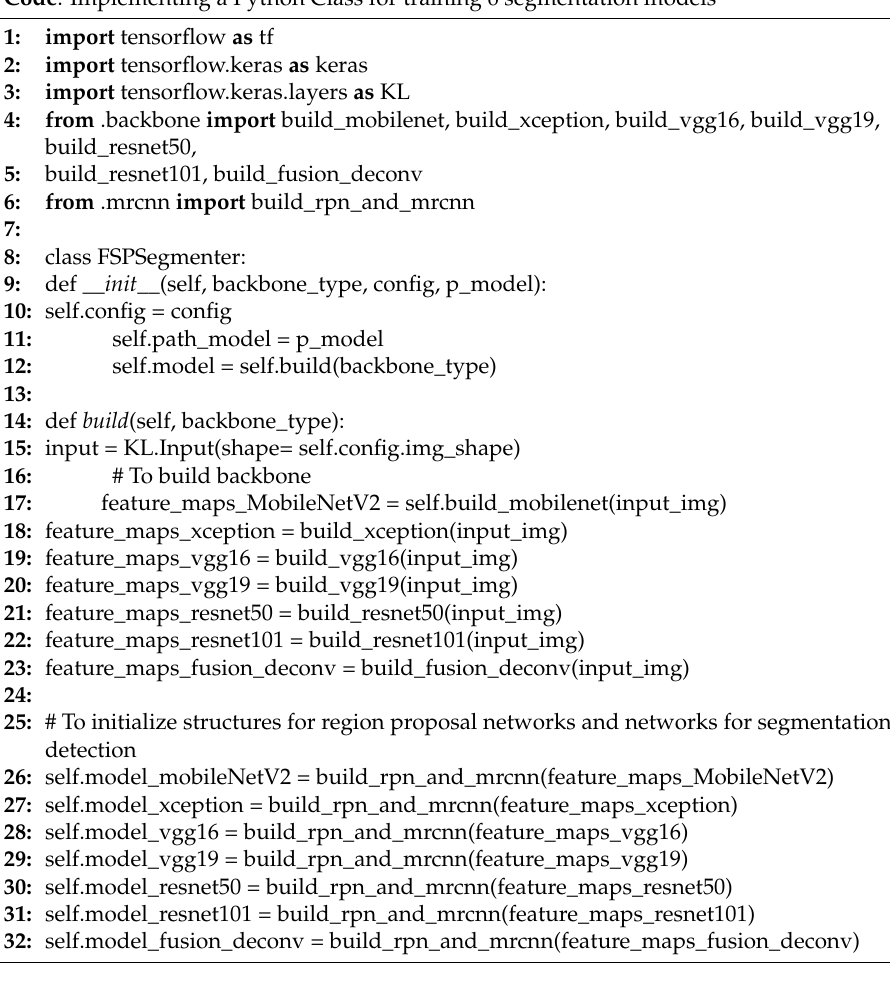
Table 5. Code segment of training segmentation models using the 6 backbone networks. Code . Implementing a Python Class for training 6 segmentation